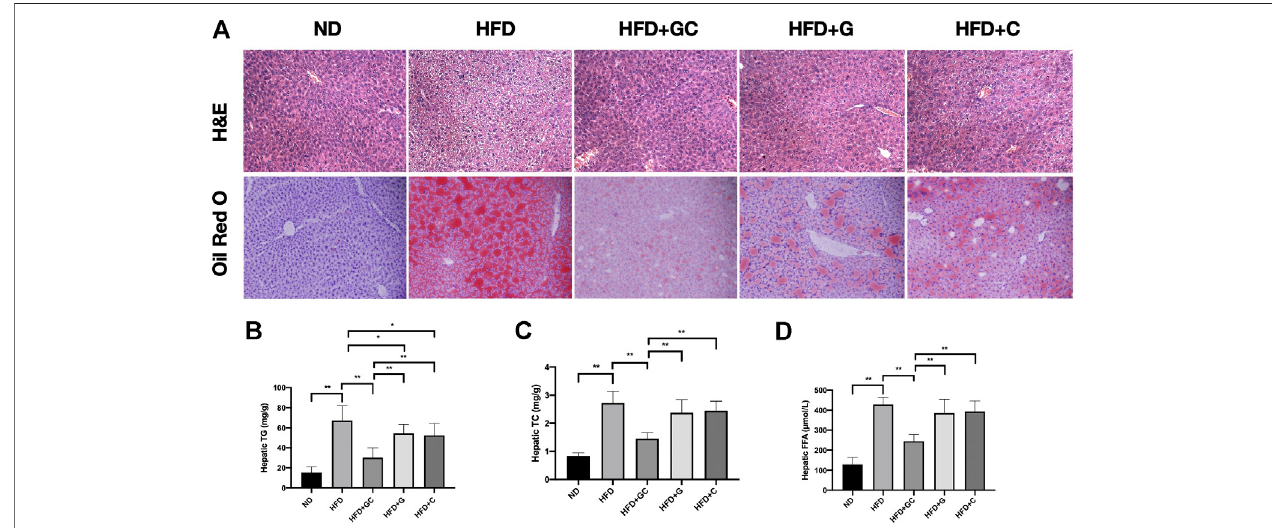
FIGURE 3 | The GC combination ameliorates hepatic fat deposition induced by high-fat diet (HFD). (A) H&E and Oil Red O staining for liver sections (200 times of magni fi cation). Hepatic TG, TC, and FFA content in each group ( n (cid:1) 10) (B,C,D) . * p < 0.05, ** p <